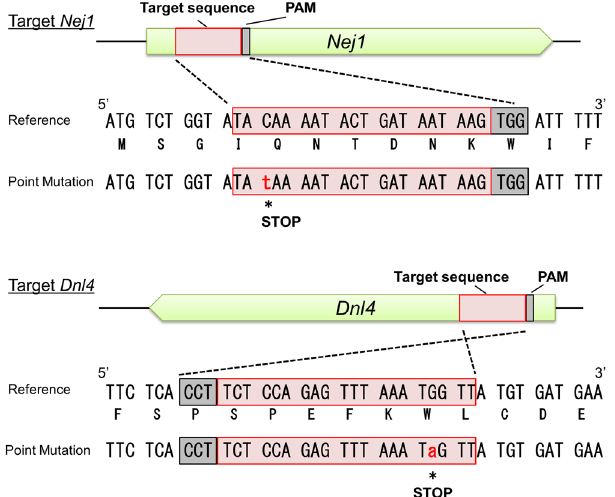
Figure 2. Induction of mutations by Target-AID. The Nej1 and Dnl4 target sites were selected for the introduction of stop codons by Target-AID. Red boxes indicate the target sites and grey boxes indicate the PAM sequences. Lower-case nucleotide in red font indicates the mutated base. The sequences of the induced mutations are shown in alignment with the reference sequences, with each predicted amino acid sequence below the respective nucleic acid